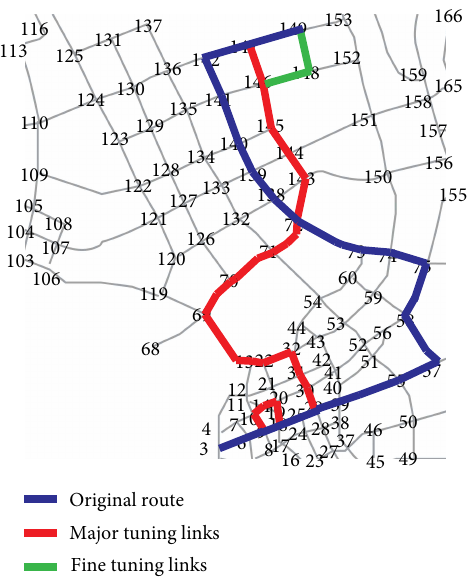
Figure 4: Stop evolution of route 2 from ACA to